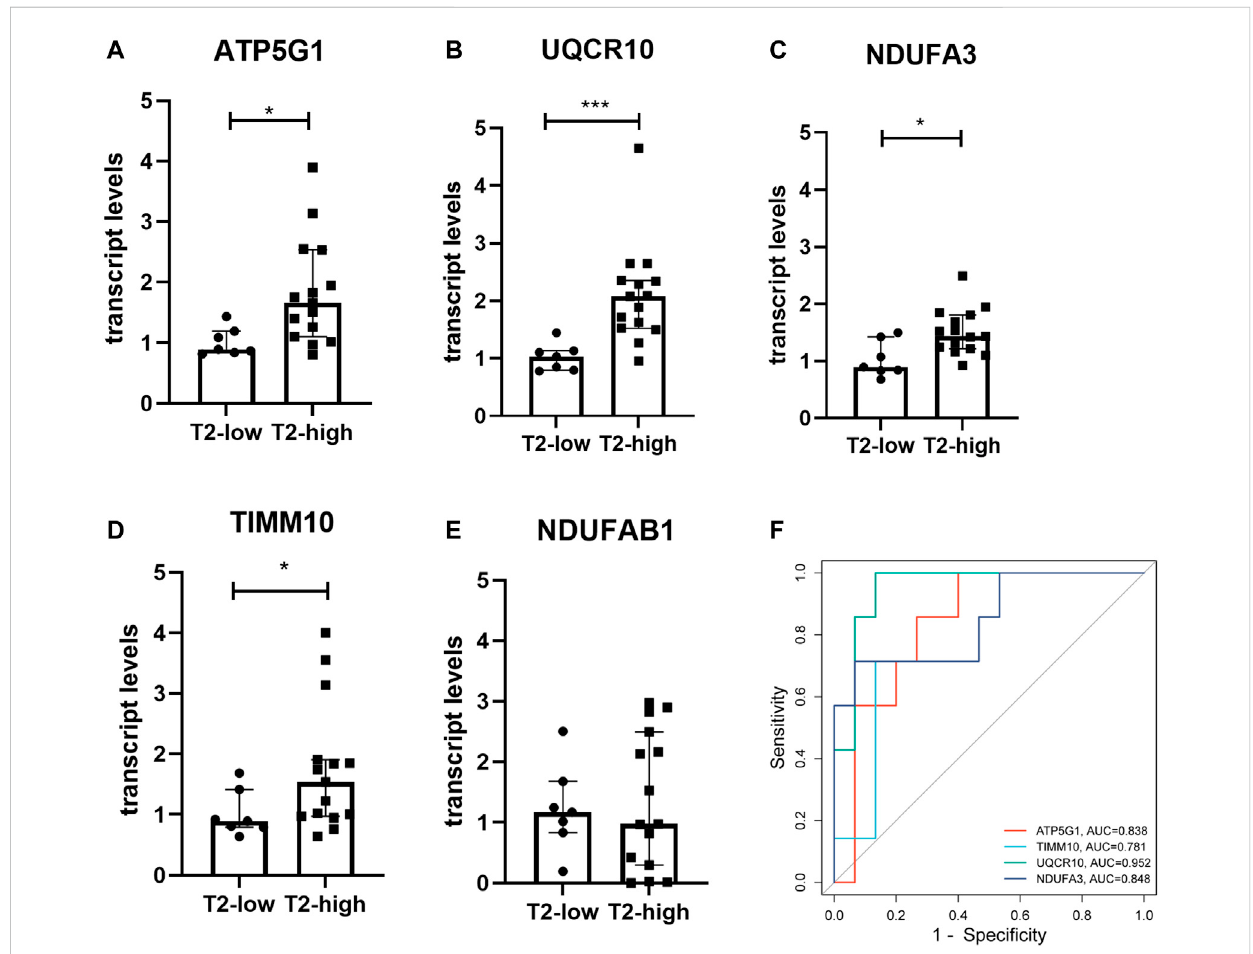
FIGURE 8 Validationofthehubgenelevelsinclinicalsamples. (A – E) qRT-PCRwasusedtoverifythehubgenelevelsof ATP5G1,NDUFAB1,UQCR10,NDUFA3, and TIMM10 in bronchial brushings from T2-high asthma patients (n = 15) and T2-low asthma patients (n = 7). *p < 0.05, ***p < 0.001. (F) ROC curve of hub genes in clinical